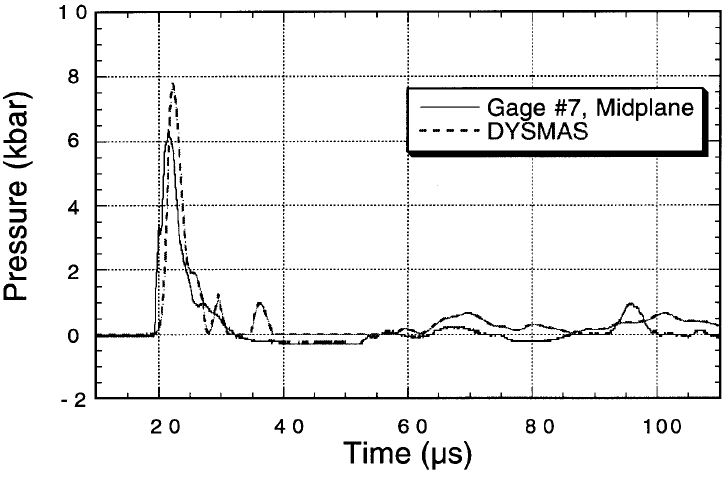
Fig. 7. Comparison of measured and calculated midplane